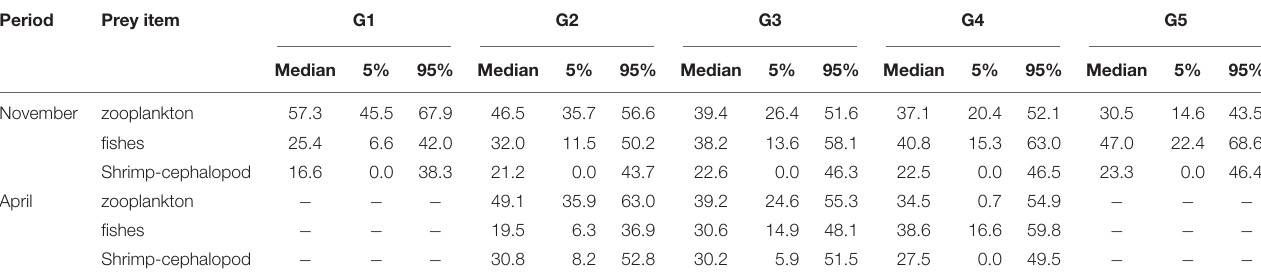
TABLE 4 | Estimates proportion of prey species in Bombay duck diet based on Bayesian mixing models using δ 15 N and δ 13 C values. Period Prey